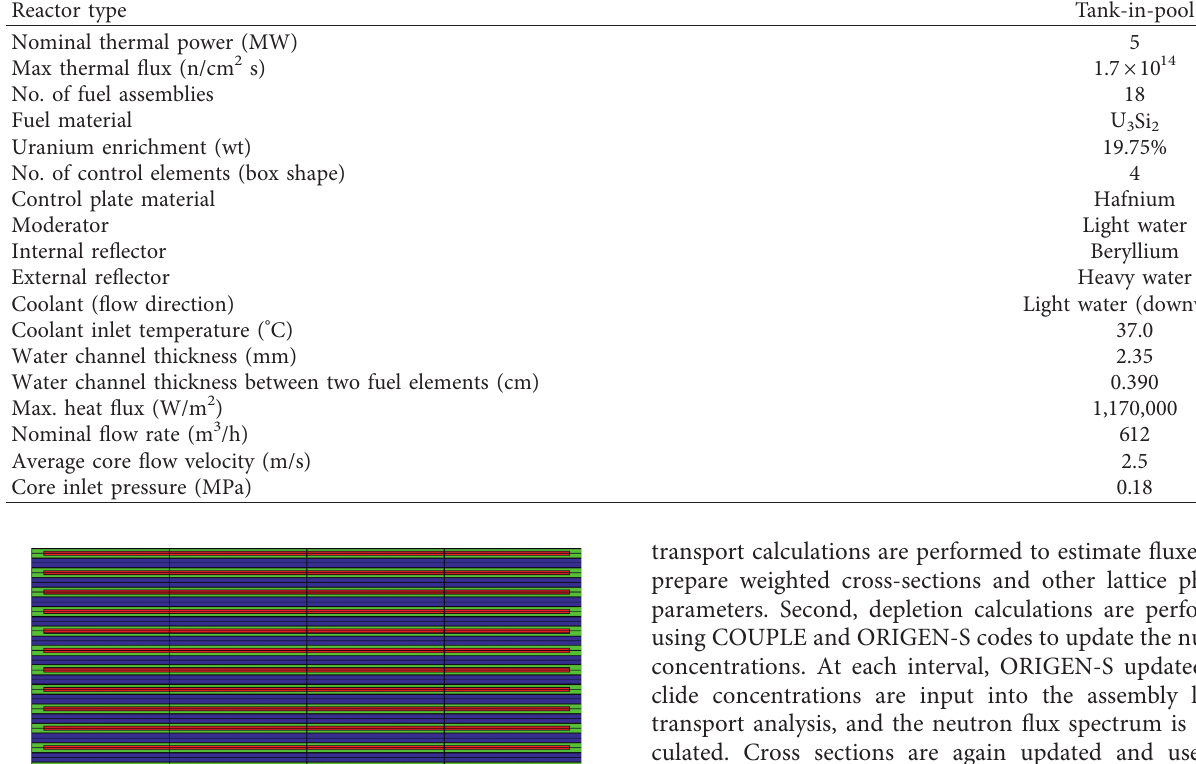
Table 1: Design characteristics of the JRTR research and training reactor.